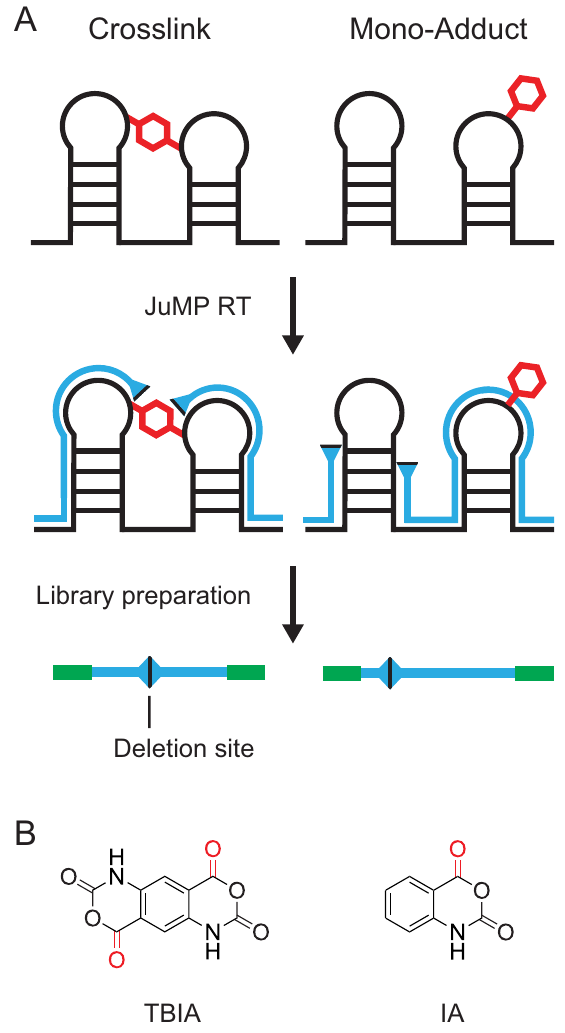
Fig 1. SHAPE-JuMP experimental overview. ( A ) RNA is crosslinked with a bi-functional SHAPE or other reagent, and the site of crosslinking is recorded as a deletion in the cDNA generated by reverse transcription under specialized RT conditions ( left ). In parallel, a control reaction that induces a mono-adduct (or no adduct) in the RNA is used to provide a control for non-crosslink-induced deletions ( right ). The cDNA is sequenced to identify deletion sites. ( B ) Examples of SHAPE reagents that form RNA crosslinks (TBIA, left ) and monoadducts (IA, right ). TBIA-dependent crosslinks, more frequent than the IA background, report through-space interactions in RNA. The ShapeJumper pipeline identifies crosslinked nucleotides from sequencing data (Fig 2). Sequencing reads are first processed to remove low per-nucleotide quality scores and to merge overlapping reads. Reads are aligned [26] with optimized parameters, as developed in this work. The resulting alignment file is analyzed with a custom algorithm to identify deletion sites; during this process ambiguous deletions are removed and exact alignments are enforced at deletion sites to improve accuracy. Deletion rates are then normalized by read depth, and background rates for a non-crosslinked control are subtracted to correct for crosslink-inde- pendent deletions. ShapeJumper works well for most classes of crosslinking strategies, includ- ing SHAPE-based methods, psoralen reagents, and UV irradiation.